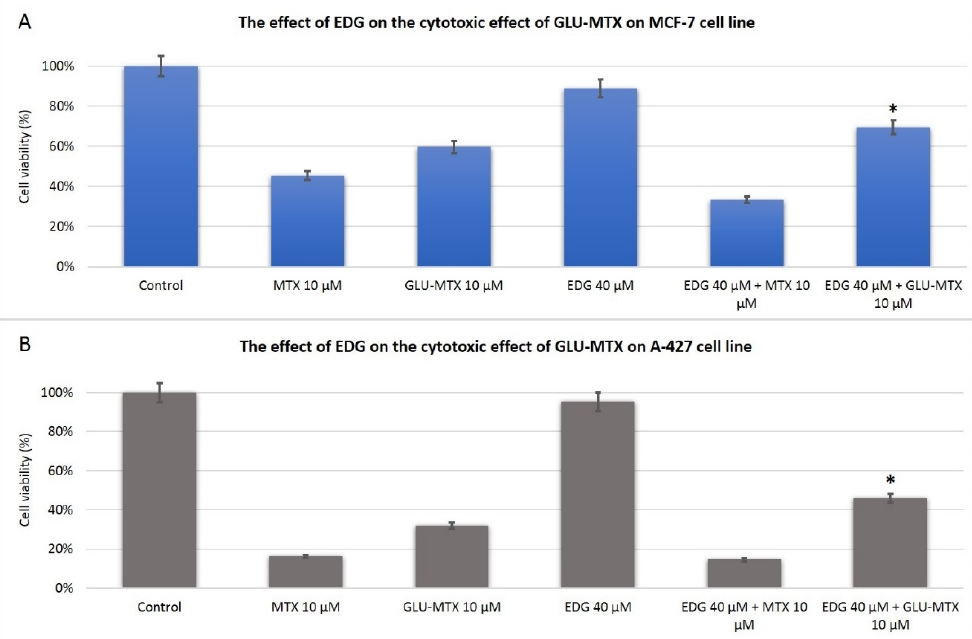
Figure 3. The effect of glucose transporter−1 (GLUT1) inhibitor 4,6-O-ethylidene-α-D-glucose (EDG) on the efficacy of free MTX and GLU–MTX treatment of ( A ) breast cancer cell line MCF-7 and ( B ) lung cancer cell line A-427. Cells were preincubated with EDG for 4 h and then incubated for 48 h with MTX or GLU–MTX. Results are presented as means ± standard deviations from two independent experiments. * p < 0.05 vs. GLU–MTX 10 μM.